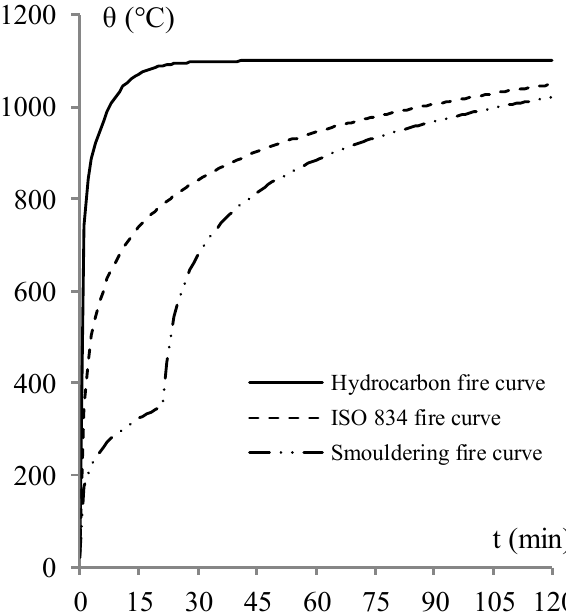
Figure 5. Fire curves.